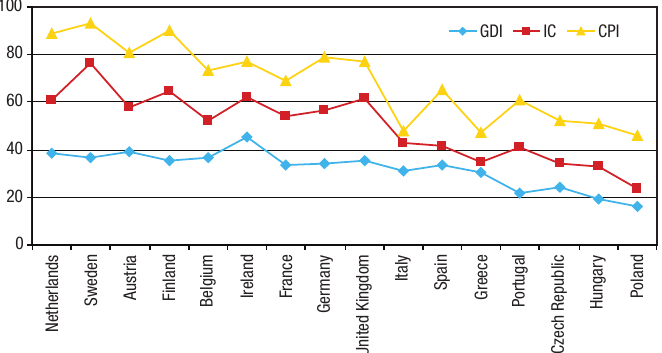
Fig. 2. The dependence between the level of corruption in a given country and its GDP and NIC Source : authors’ own